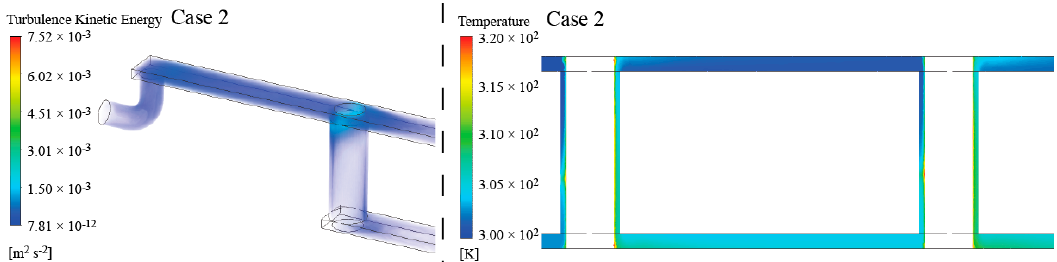
Figure 8. 3D visualization of turbulent kinetic energy in the region between the inlet and the first heat exchange chamber (left part of the figure), and a side view of the temperature field where the gradual heating of the heat transfer medium behind the second and third heat exchange chamber is visible (right part of the figure).